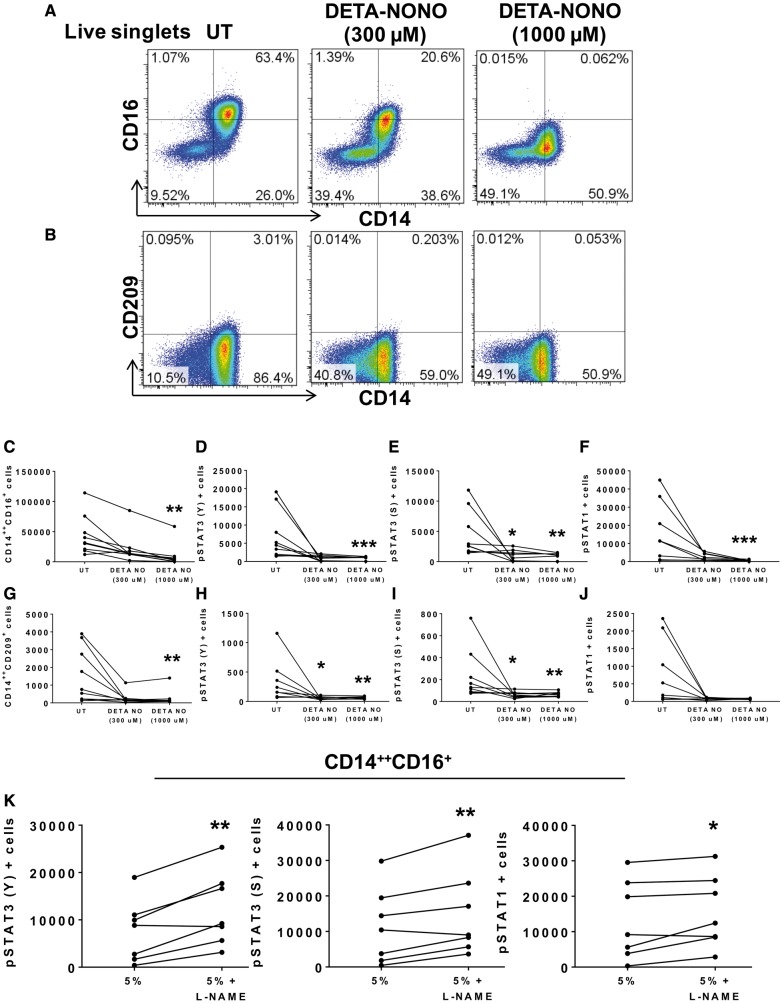
Exposure of monocytes to NO donor inhibits human monocyte conversion and activation to its derived populations. Human CD14+ monocytes were isolated from buffy coats of normal human volunteers and cultured alone in untreated (UT) conditions, DETA-NONOate (DETA-NONO), an NO donor, at 300 µM or DETA-NONO at 1000 µM concentrations in static conditions for 48 h. (A) Flow cytometry representatives are shown for the CD14++CD16+ intermediate monocyte and (B) the CD14++CD209+ population. (C) Values for each subject without and with DETA-NONO are shown for the total number of cells from the CD14++CD16+ intermediate monocytes and for the total number of cells expressing (D) pSTAT3 (Y), (E) pSTAT3 (S), and (F) pSTAT1 within this population. (G) Effect of DETA-NONO on the number of CD14++CD209+ cells and the expression of (H) pSTAT3 (Y), (I) pSTAT3 (S), and (J) pSTAT1 for each subject. A total of n= 9 participants per group were used for these experiments. (K) Human CD14+ monocytes were cultured with HAECs exposed to 5% stretch or 5% plus NO synthase inhibitor, L-NAME (1000 µM) for 48 h. The number of CD14++CD16+ intermediate monocyte population expressing pSTAT3 (Y), pSTAT3 (S), and pSTAT1 for each subject are connected by lines. A total of n = 7 participants per group were used. For (C–J) the nonparametric Friedman’s test followed by Dunn’s multiple comparison tests was employed. For (K) a one-tailed paired t-tests was used (*P < 0.05, **P < 0.01, ***P < 0.001).